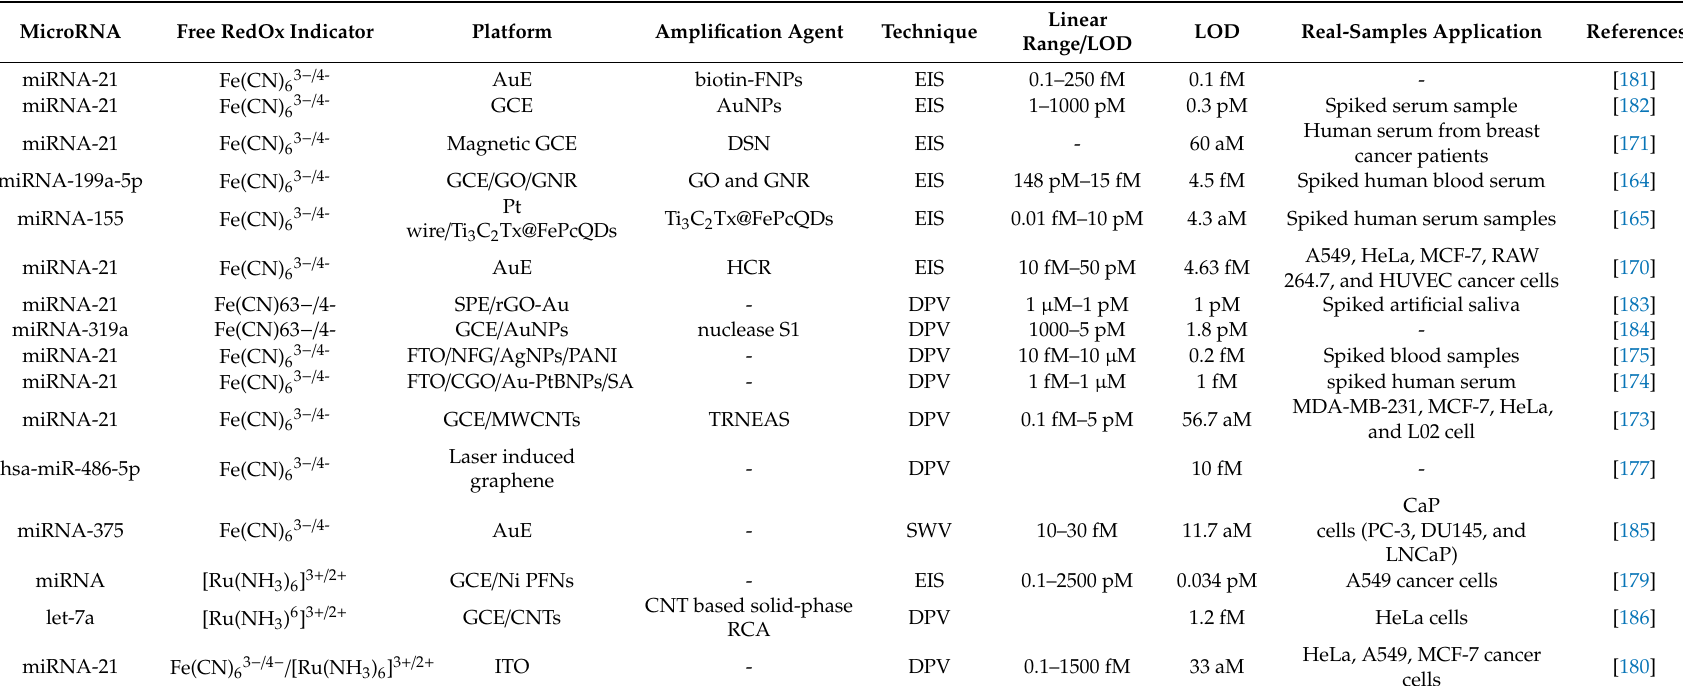
Table 5. Current sensitive electrochemical biosensors using free RedOx